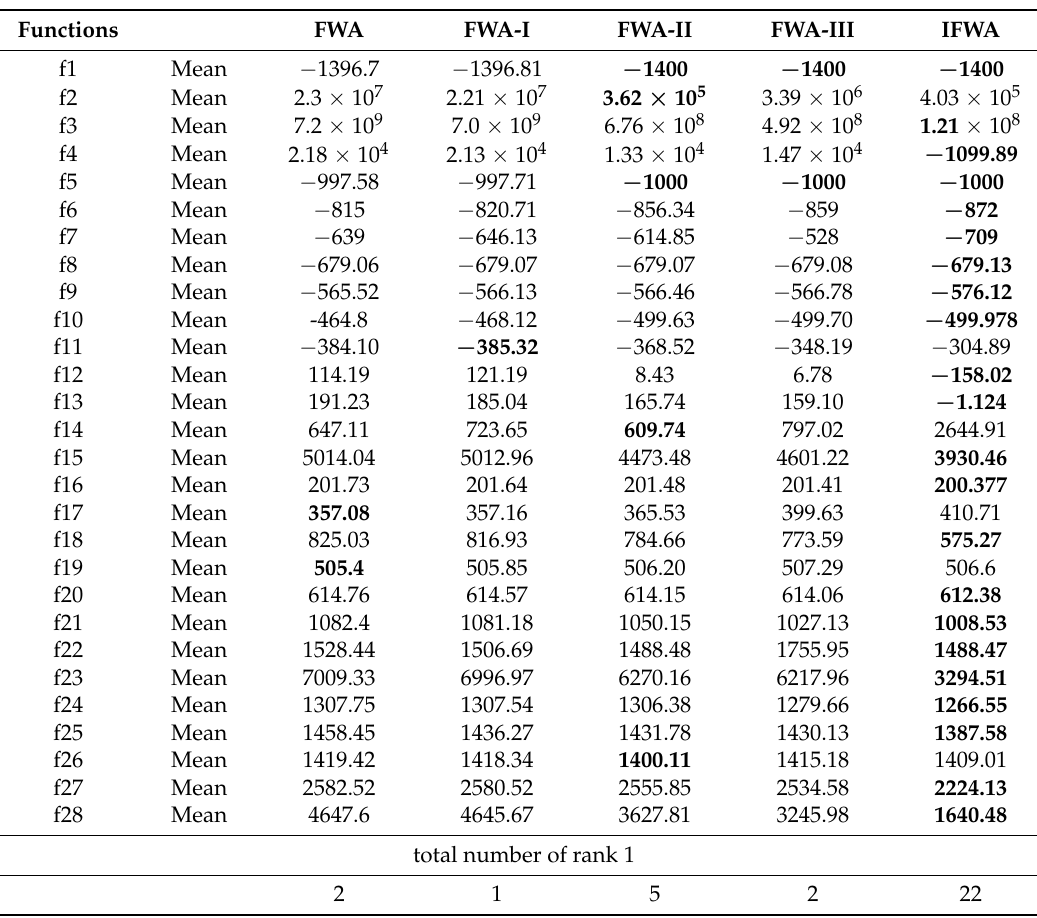
Table 2. Average fitness value and total number of rank